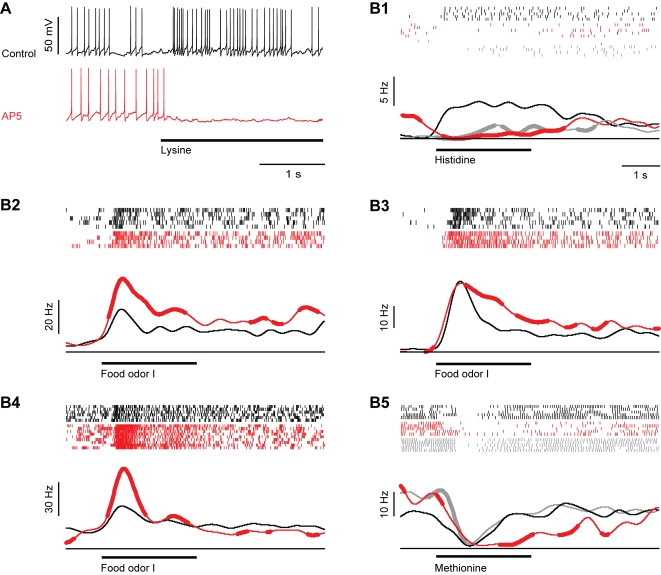
Effect of the NMDA receptor antagonist, AP5, on odor responses of mitral cells.(A) Whole-cell recording of a mitral cell response to odor stimulation (Lys, 10 µM; bar) before (black) and during (red) application of AP5. (B1–B5) Five examples illustrating effects of AP5 on odor responses. Conventions as in Fig. 3. Responses are from different cells and were recorded in the whole-cell, cell-attached or loose-patch configuration.